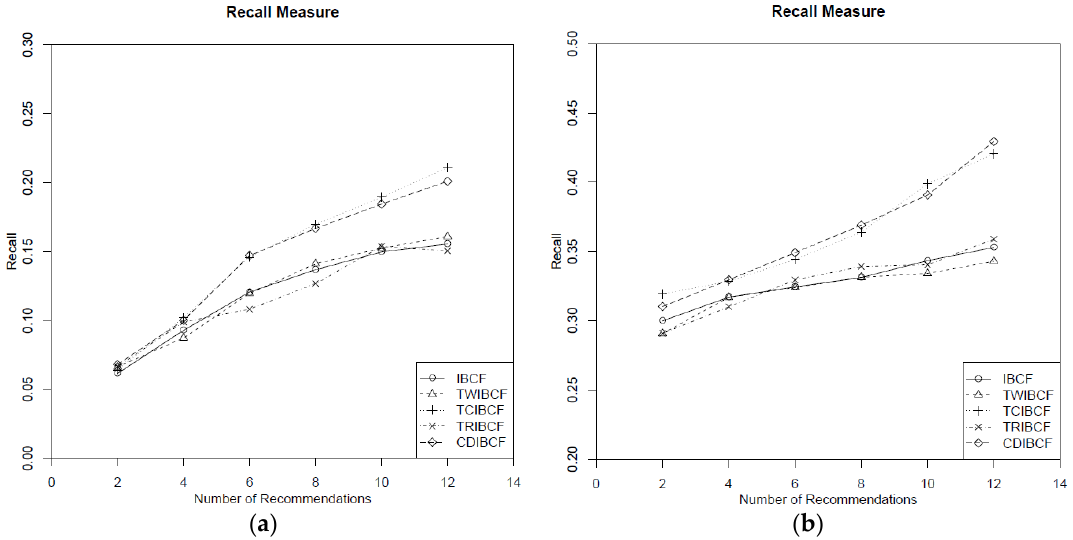
Figure 7. Precision results with MovieLens dataset ( a ) and Netflix dataset ( b ). Figure 8. Recall results with MovieLens dataset ( a ) and Netflix dataset ( b ).